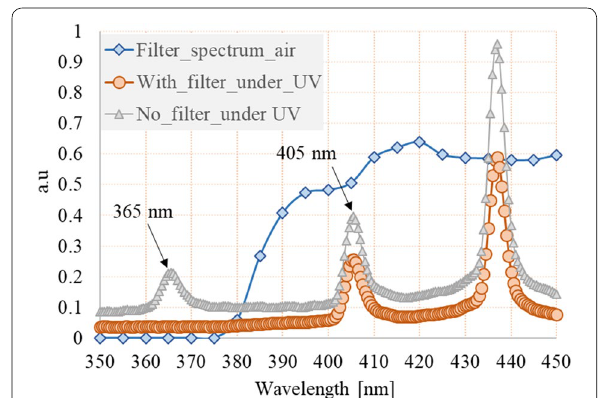
Fig. 3 UV wavelength spectrum measured under a standard UV exposure system: without filter (triangle), with filter (circle), and a spectrum measurement of the filter using a spectrum analyzer